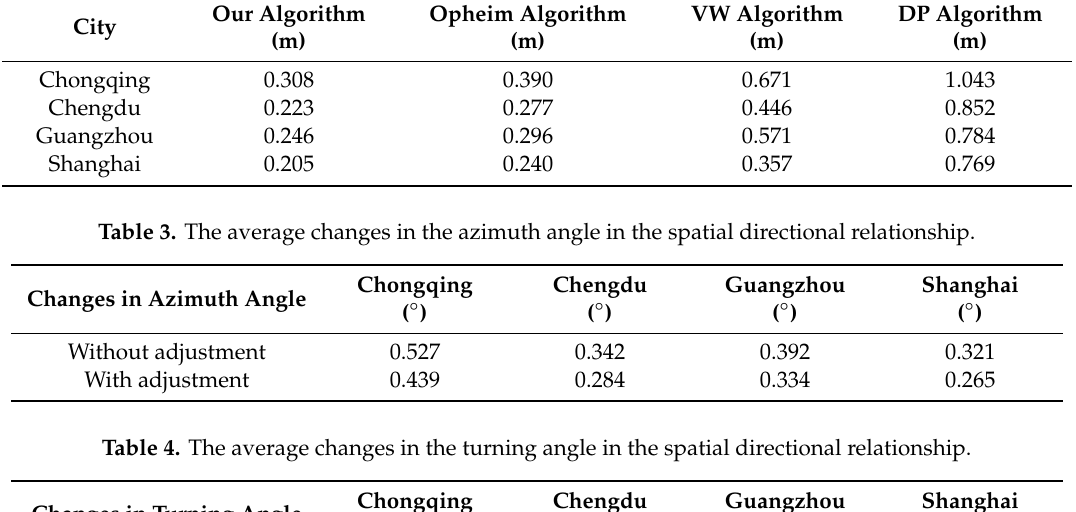
Figure 18. Maintenance of spatial directional relationship at special nodes using e-GA. The blue line represents the original road and the orange line represents the road with five-digit precision. V 1 and V 2 are nodes. Table 2. The average Hausdor ff distance statistics of di ff erent methods.